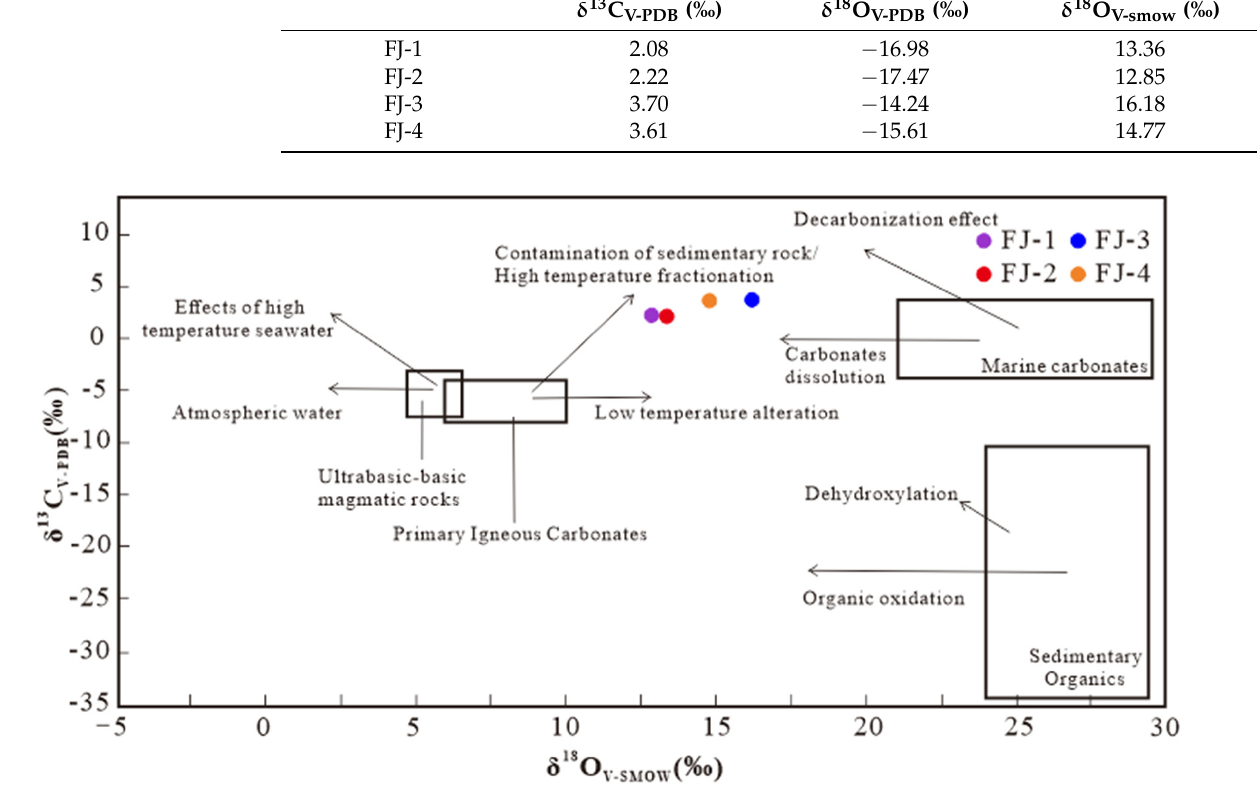
Figure 6. δ 13 C- δ 18 O diagram of Fujian calcite samples